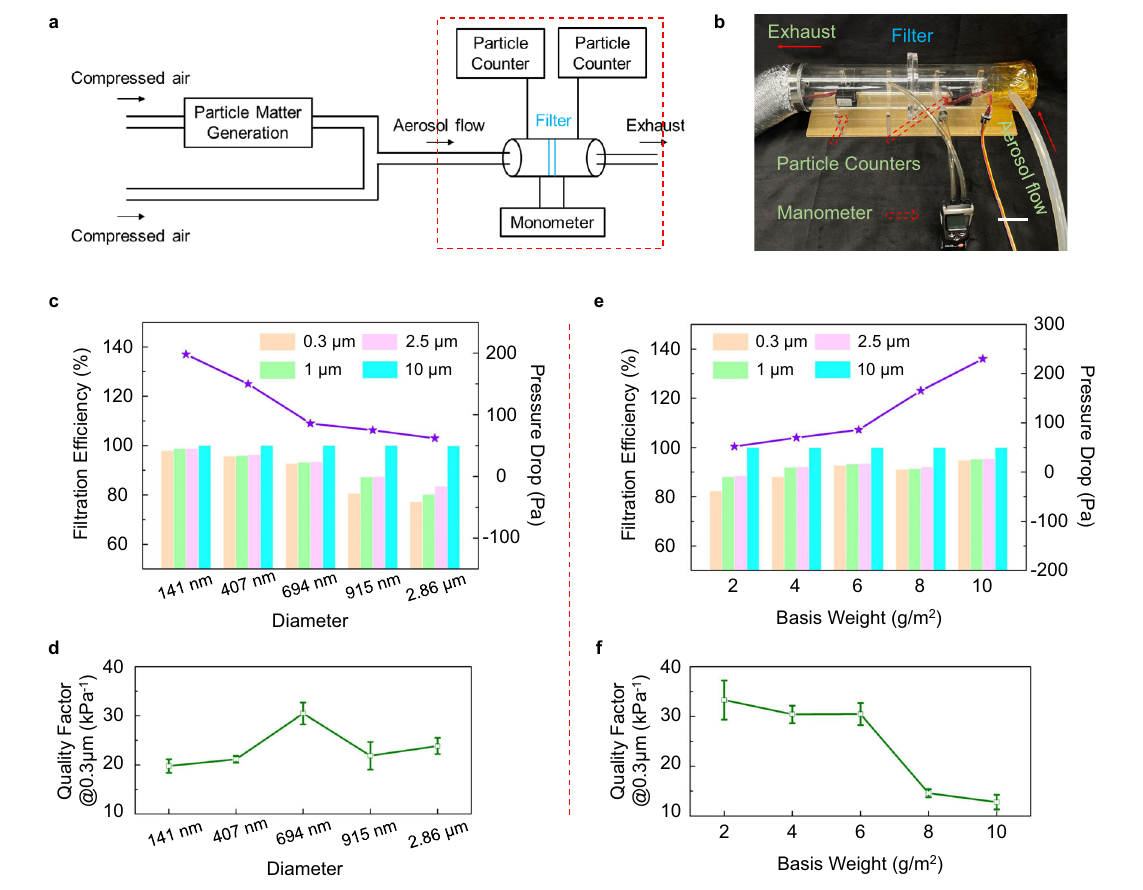
Fig. 2 | Filtration performance of the electrospun PVDF fi lter media. a Experimental setup for the fi ltration performance evaluation. b Optical photo- graphshowingthecorepartofthe fi ltertestingplatforminsidethedashedboxinA. Scalebar:5cm. c Fiberdiameter-dependent fi ltrationef fi ciencyandpressuredrop, and d corresponding quality factor. e Basis weight-dependent fi ltration ef fi ciency